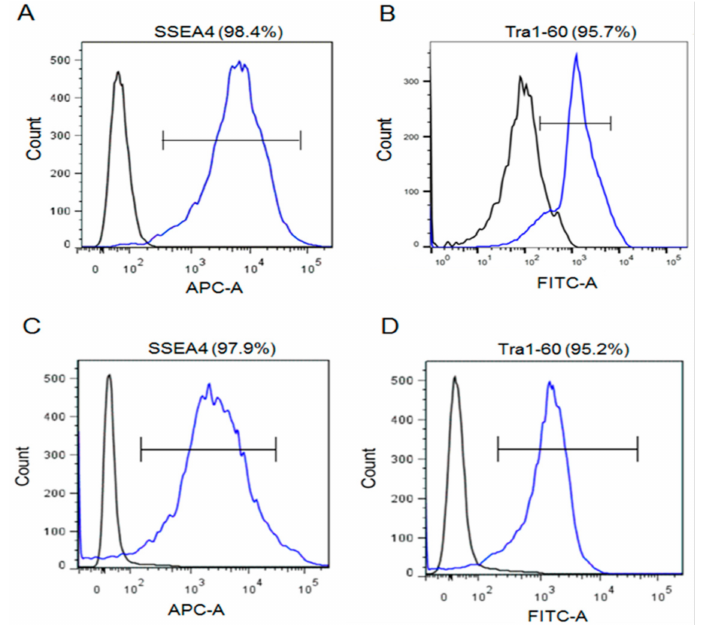
Figure 2. FACS analysis of H9 hESCs after 10 passages cultured in homemade E8 medium containing either hFGF-2 ( A , B ) or hDJ-1 ( C , D ) for the pluripotency marker SSEA4 ( A , C ) or Tra1-60 ( B , D ).